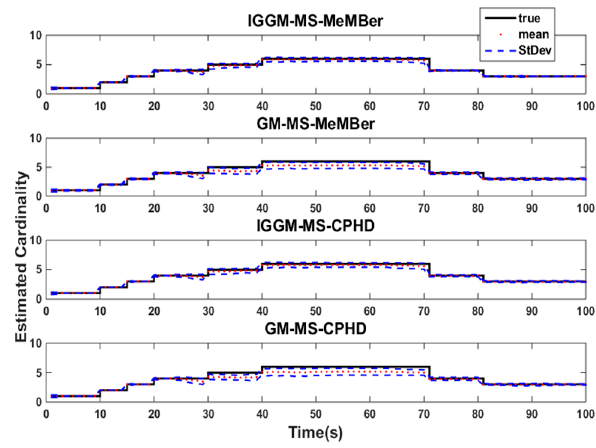
Figure 5. Estimation of the cardinality.